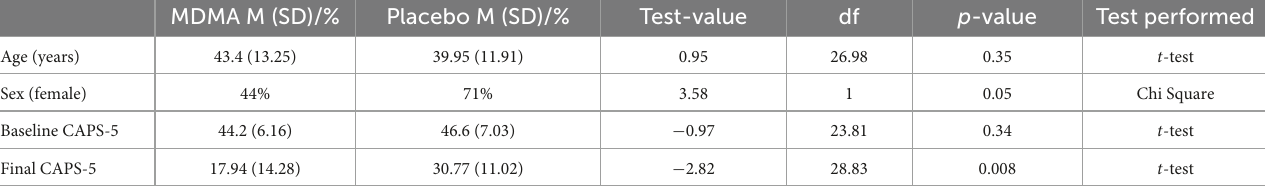
Table 2 ). Ten of these sites resided in open sea regions, two on south shore regions, two on north shore regions, two on an island, and one on a south shelf. The site with the largest (cid:49) effect size survived FDR correction (open sea: cg08276280; B = 42.12, p = 0.005–pre-FDR correction) and is depicted in Figures 2A, B .